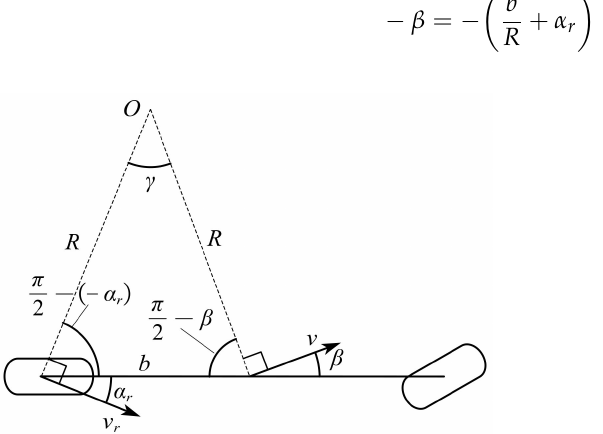
Figure 5. Two-degree-of-freedom model diagram.